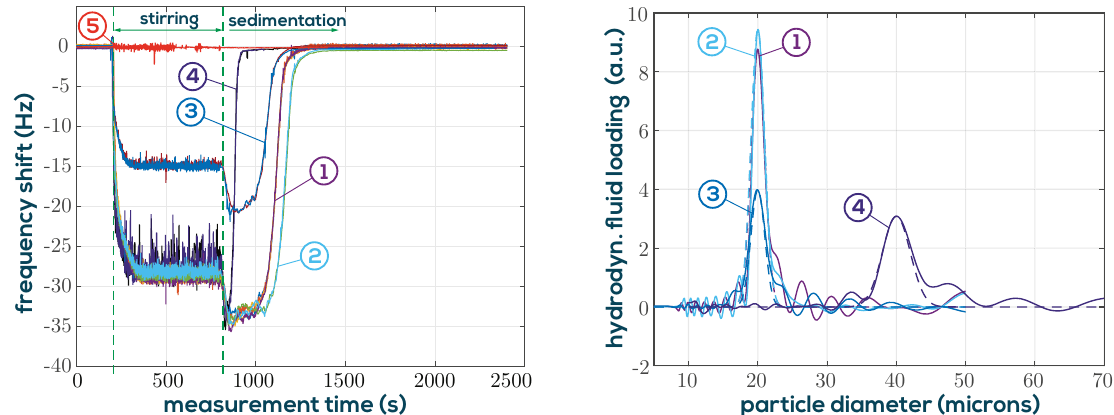
Figure 14. Left : The resonance frequencies are measured for a cyclically activated magnetic stirrer. (1) Shows a dispersion of PMMA particles of 20 µ m nominal diameter with a concentration of 4.68%. Traces (2) show measurements with the sensor immersed 2.125 mm deeper, which results in a delayed particle front. For trace (3), the concentration is halved at lower immersion. For (4), particles of 40 µ m diameter of the same concentration are used. They pass with accordingly higher velocities. (5) shows the measurement using clear DI-water for reference. The noise while stirring is higher due to mechanical vibration. Right : Calculated distributions from the resonance frequency characteristics (traces 1–4) in the left figure. The dashed lines shown Gaussian distributions centered at 20 µ m and 40 µ m with the standard deviation given in the datasheet of the